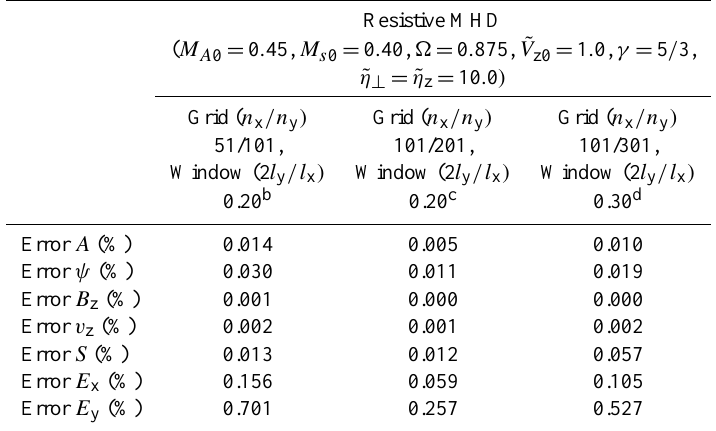
Table 1. Reconstruction errors a .